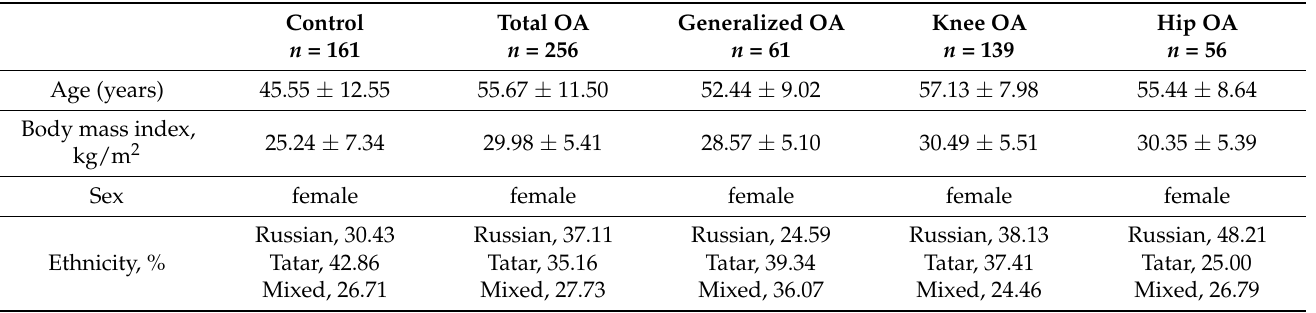
Table 1. Characteristics of the study